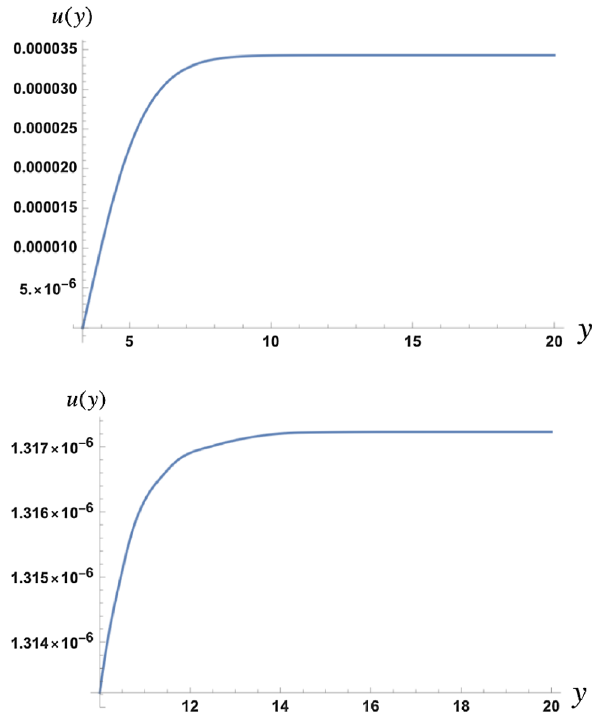
Fig. 5 Evolution of u ( y ) for μ = 30 (left) and μ = 20